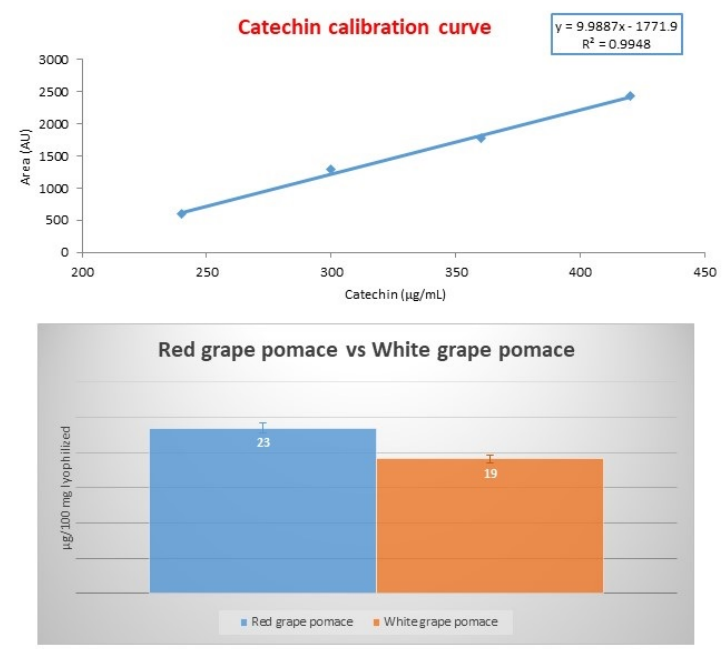
Figure 10. ( A ) Calibration curve of catechin for sample extracts derived from red and white grape pomace; ( B ) comparison of catechin content in red and white grape pomace extracts.